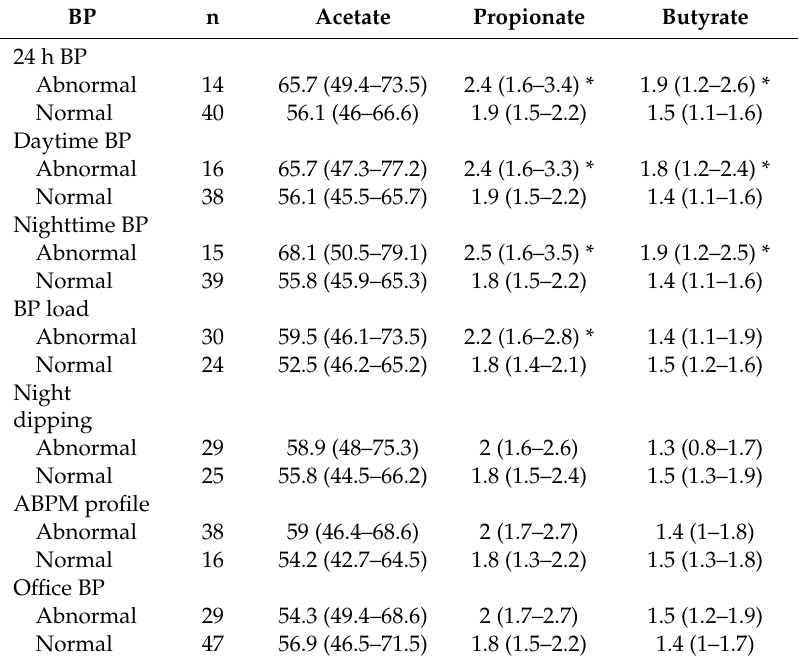
Table 4. Plasma short chain fatty acid (SCFA) levels vs. BP and ABPM profile in children with CKD. BP n Acetate Propionate Butyrate 24 h